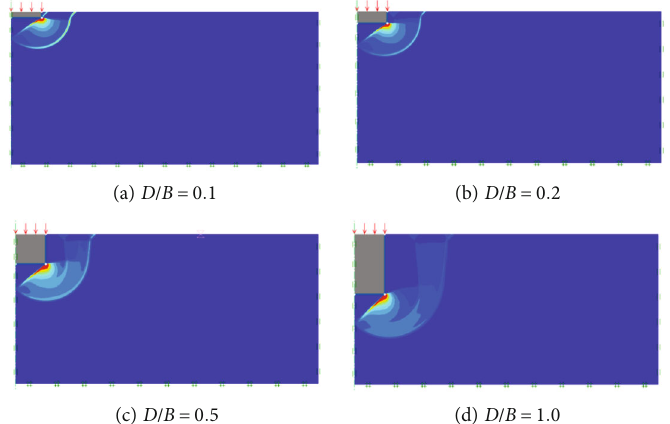
Figure 6: Failure patterns of the ring foundation with di ff erent embedment depth ratios.